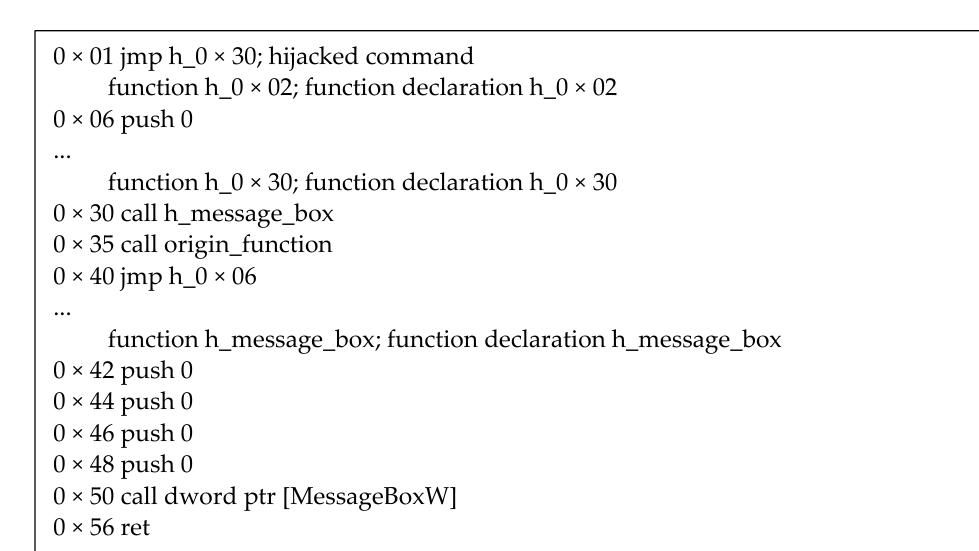
Figure 2. Original malware assembly instructions.